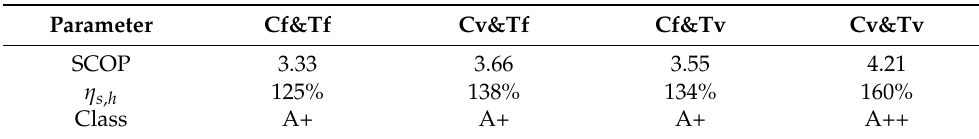
Table 4. SCOP, seasonal space heating efficiency, and energy efficiency class for the four different heat pump